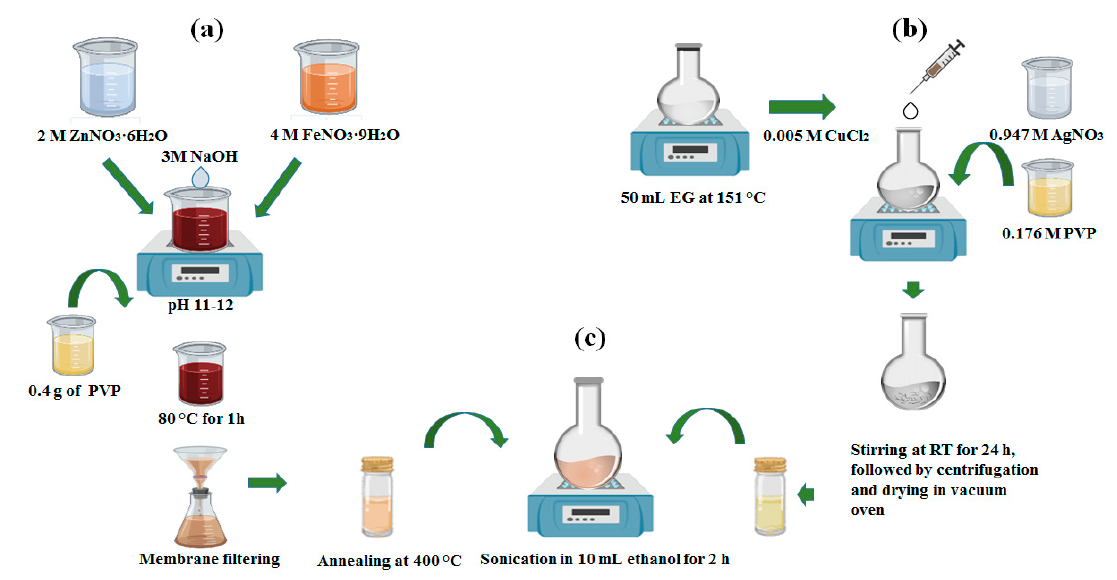
Figure 1. Synthesis procedures of ( a ) ZnFe 2 O 4 NPs with PVP capping, ( b ) AgNWs, and ( c ) AgNWs combined with ZnFe 2 O 4 NPs (ZnFe 2 O 4 @AgNWs hybrid nanostructures).